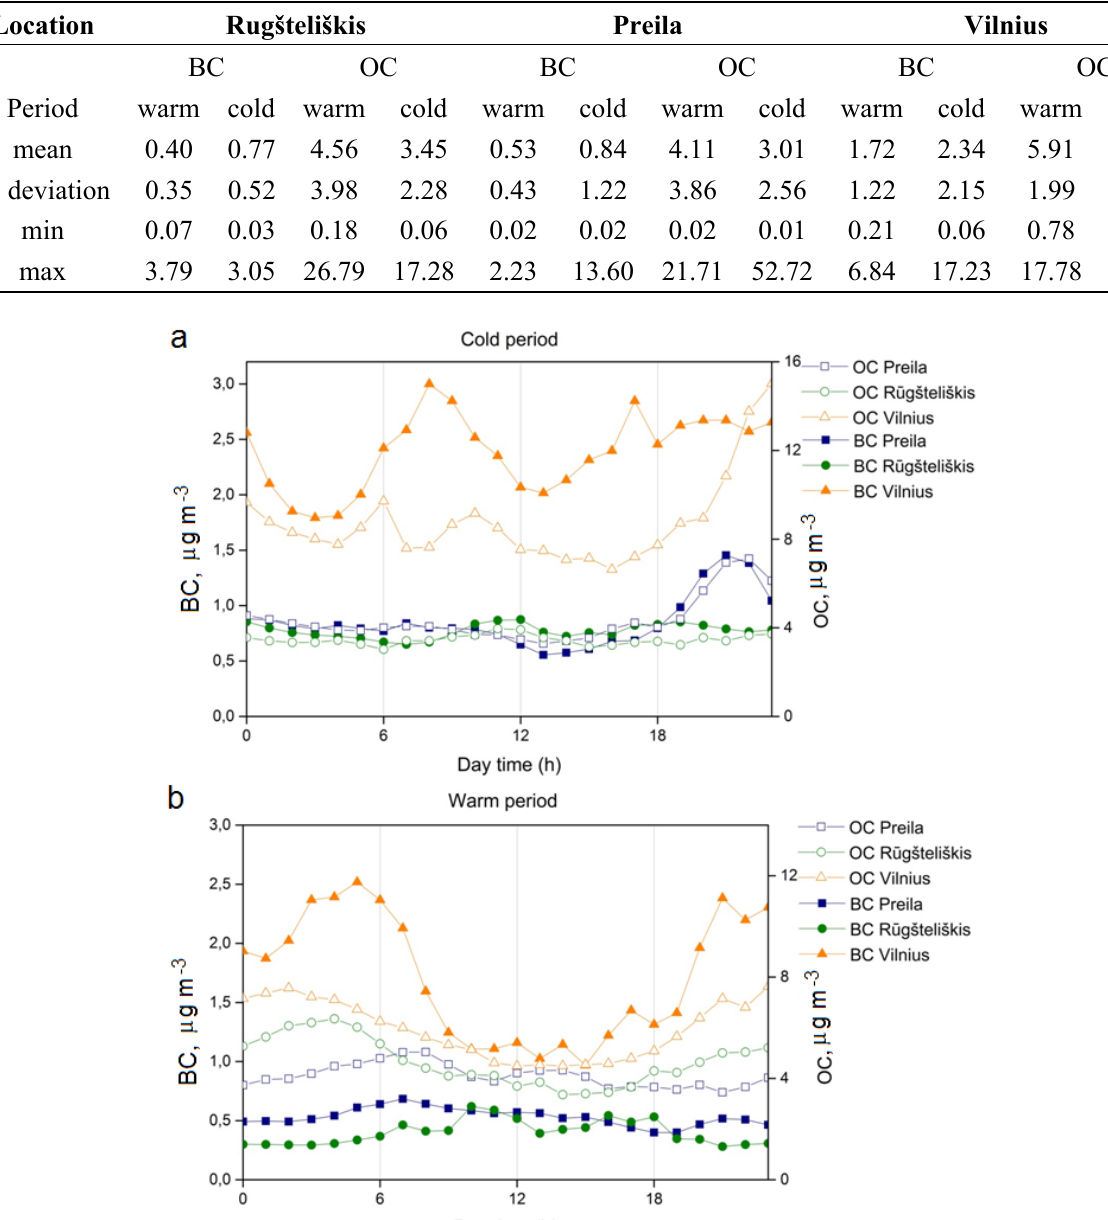
Table 1. The concentrations (µg·m − 3 ) of black carbon (BC) and organic carbon (OC) during warm and cold periods at the rural (R ū gšteliškis), coastal/marine (Preila) and background urban (Vilnius) environments.